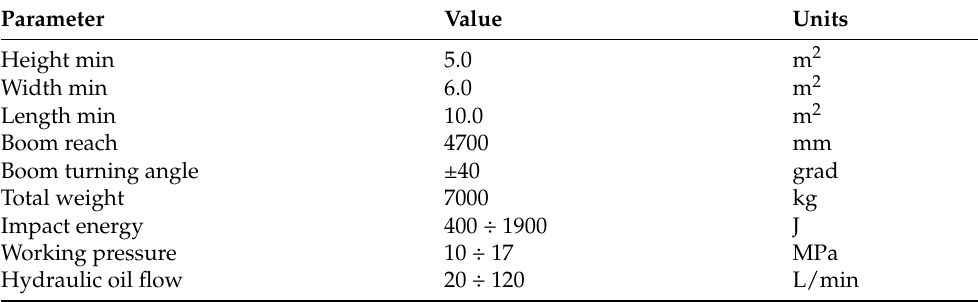
Table 2. Parameters of the hydraulic manipulator and hammer (KGHM ZANAM [88]).